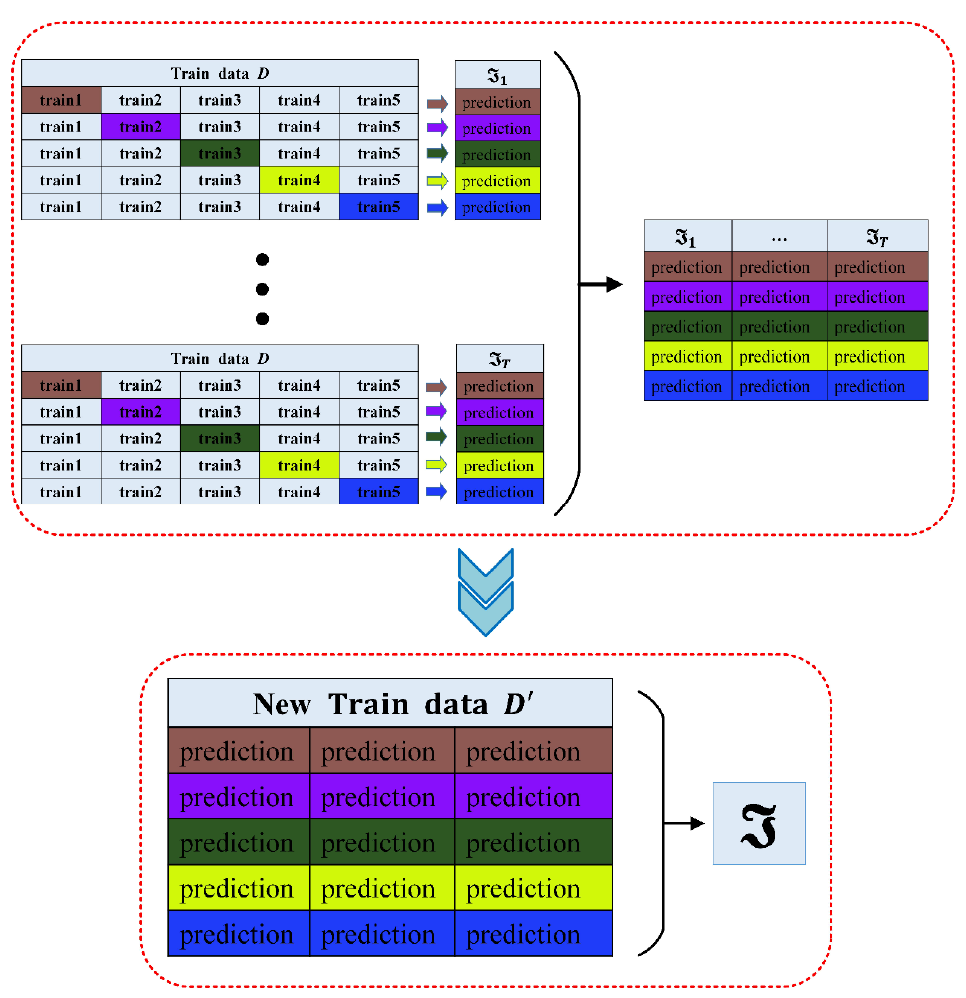
Figure 3. Stacking generalization (SG) schematic diagram.